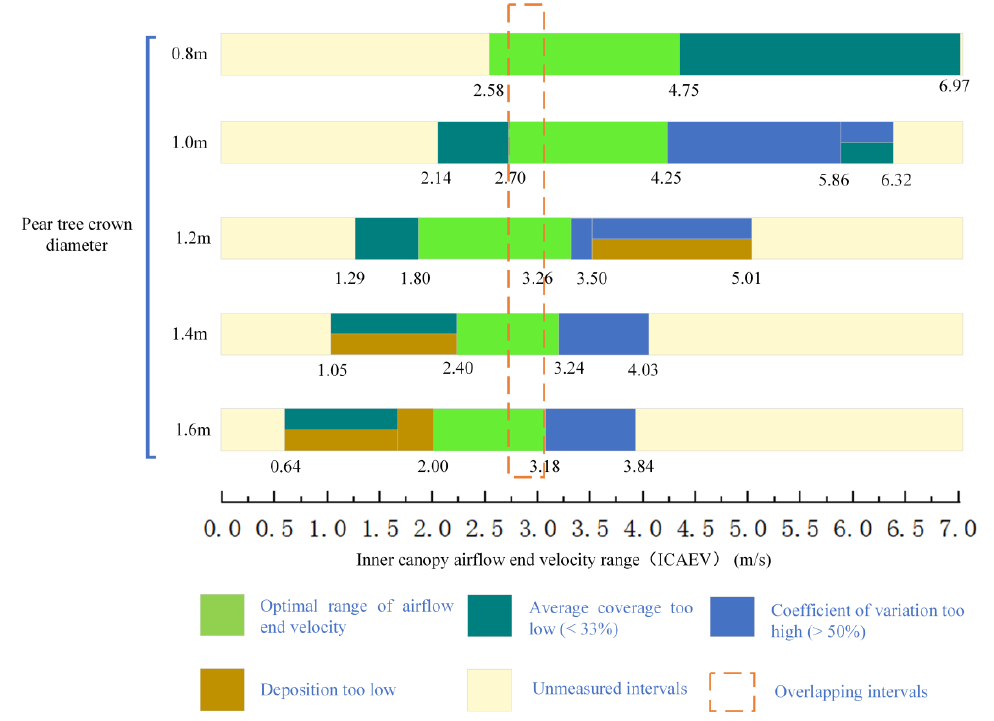
Figure 8. Corresponding suitable inner canopy airflow end velocity intervals for different crown diameters.